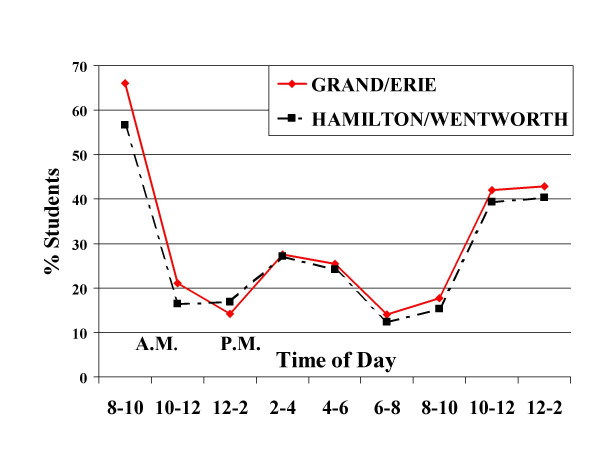
Per cent students feeling "really sleepy" at different times of day.